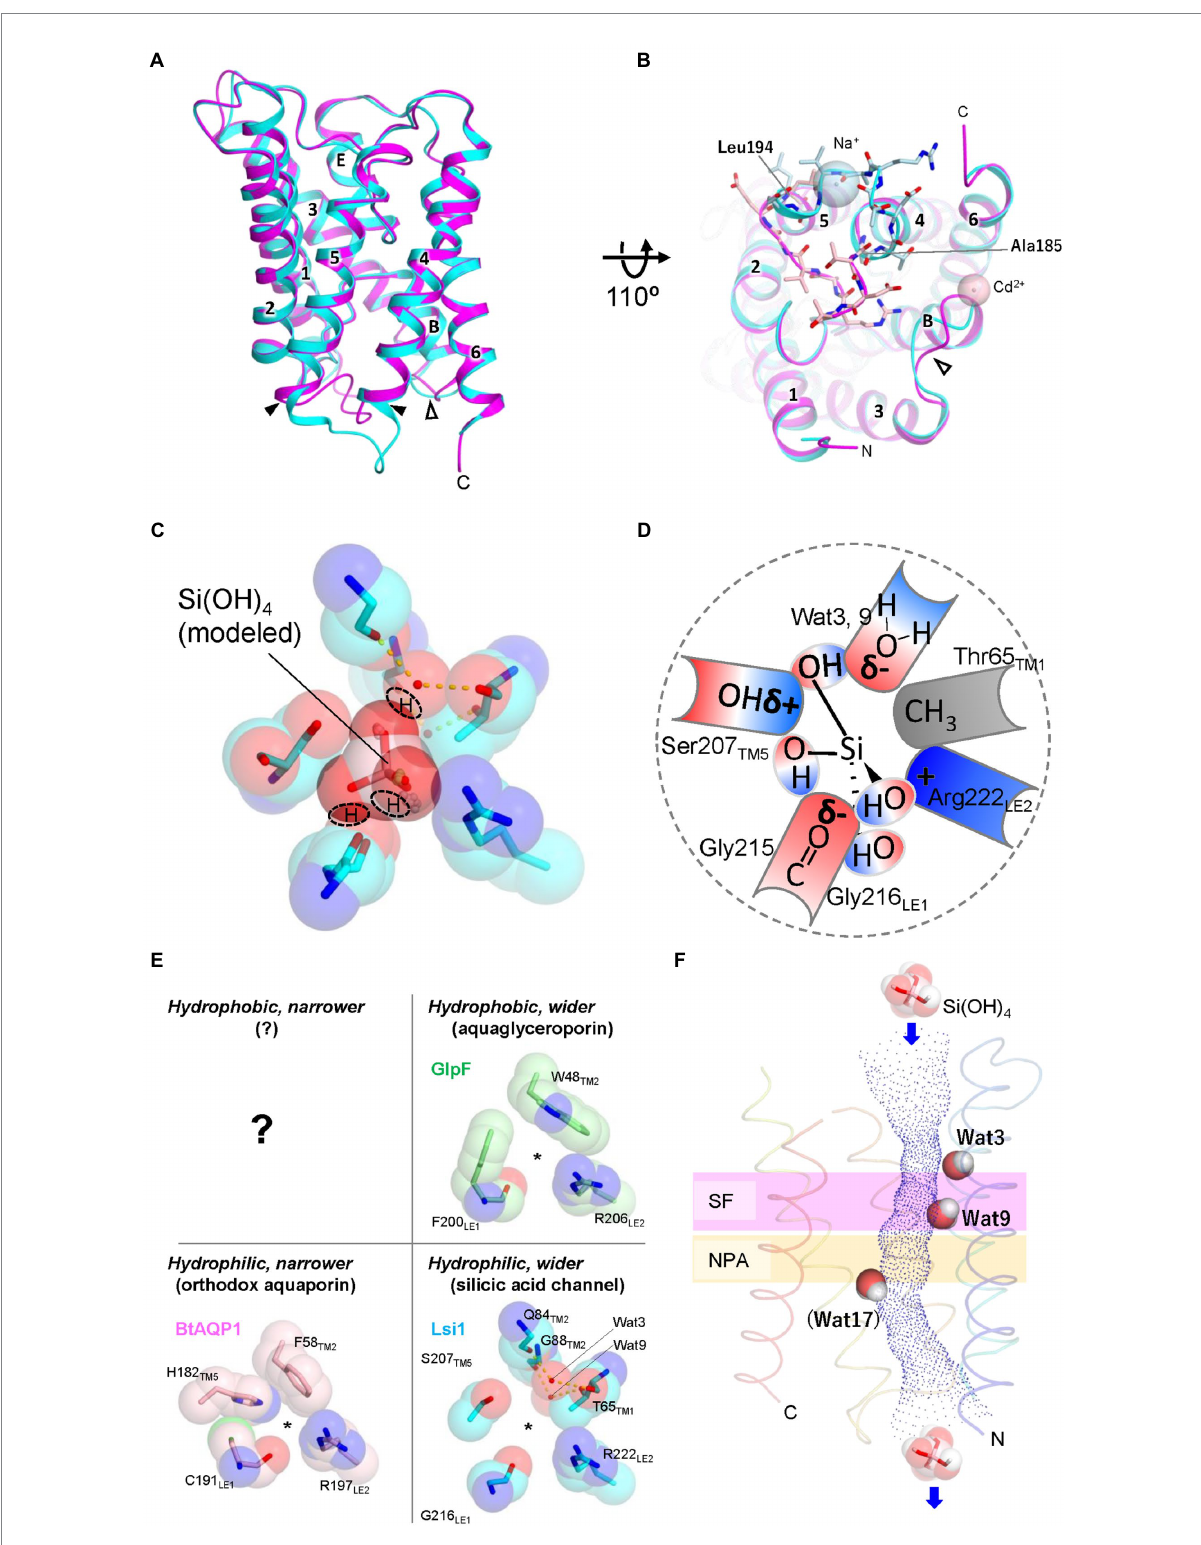
FIGURE 2 Structures of Lsi1 and silicic acid permeation model in SF. (A) Superposition of the Lsi1 structures in the open state (PDB 7CJS, cyan) and closed state (PDB 7NL4, magenta). Numbers indicate TM1~6; Alphabets indicate Short helices B and E. The solid and open arrowheads indicate loop D and loop B, respectively. (B) The view from the Intracellular side. Amino acid residues of loop D are shown as stick representations in light blue (open state) and light pink (closed state). Spheres indicate Na + ion (open state, light blue), and Cd 2+ ion (closed state, light pink). In the closed